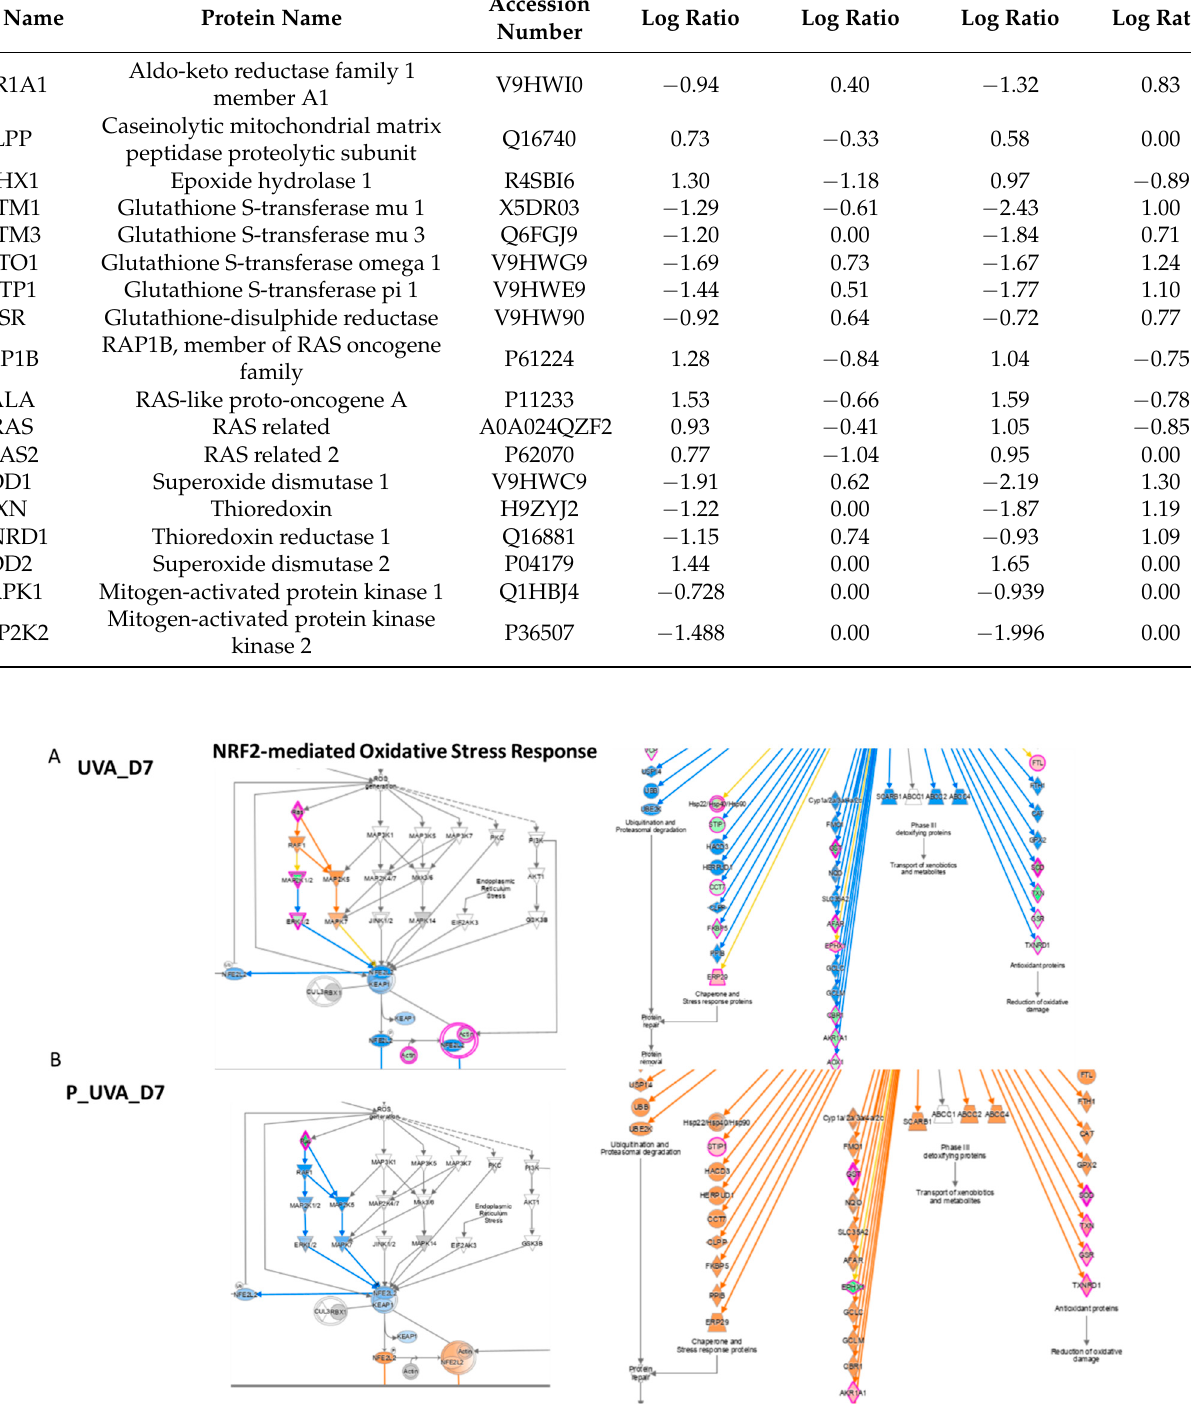
Figure 5. Genes involved in Nrf2 modulation after UVA exposure vs. control ( A ) after carnosine treatment ( B ) P_UVA vs. UVA (IPA). Red shows the increased genes, blue shows the decreased genes, grey shows the unaltered genes.